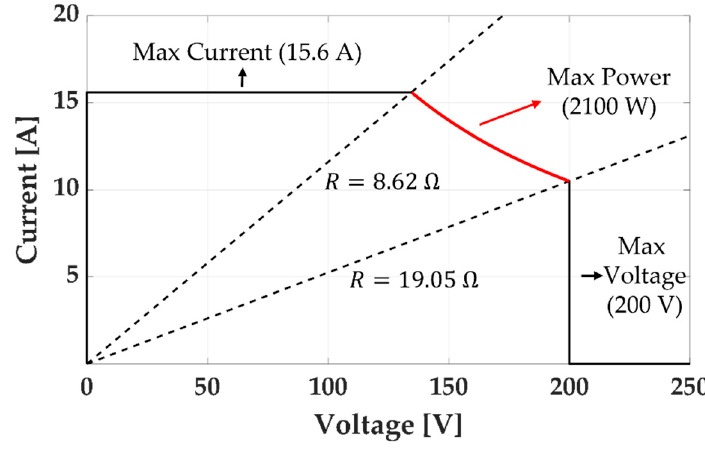
Figure 7. Output range of the power supply unit (3001iX by California Instruments).